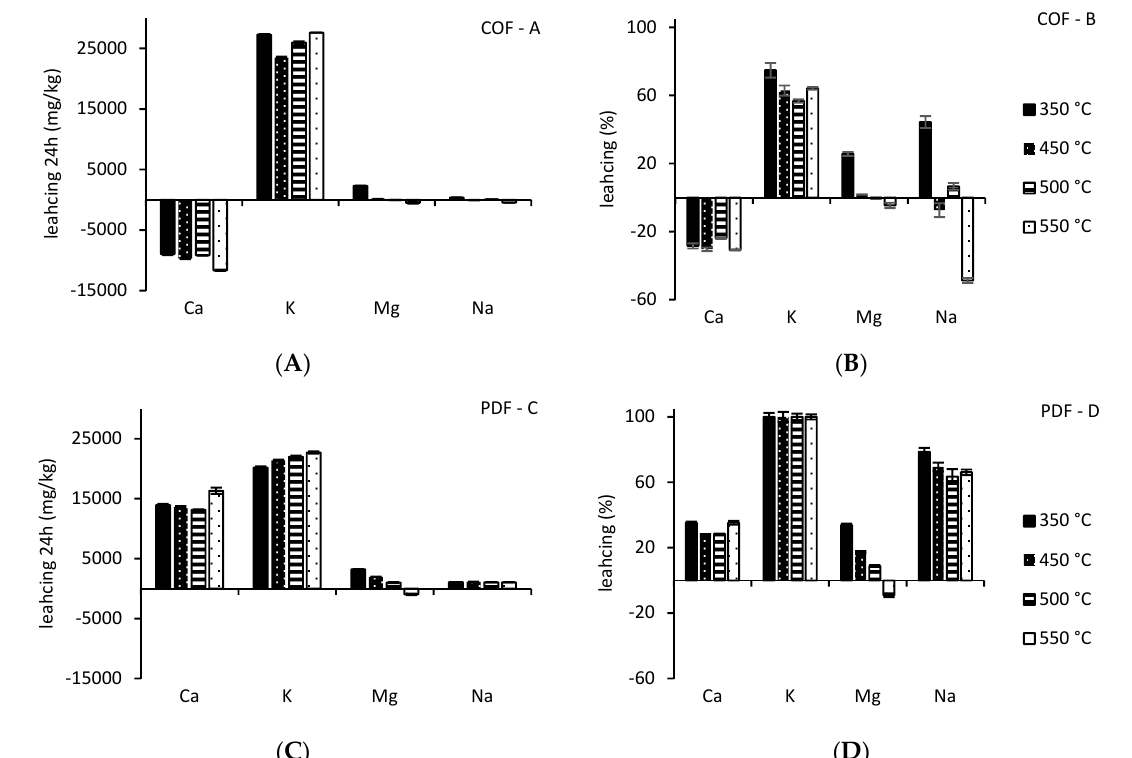
Figure 3. Leached concentration and % leached (leached concentration/total concentration × 100) of elements out of COF ( A , B ) and PDF ( C , D ) biochar produced at different pyrolysis temperatures in the lab-scale reactor after 24 h in milli-q water. COF = coffee husks and PDF = palm date fronds.